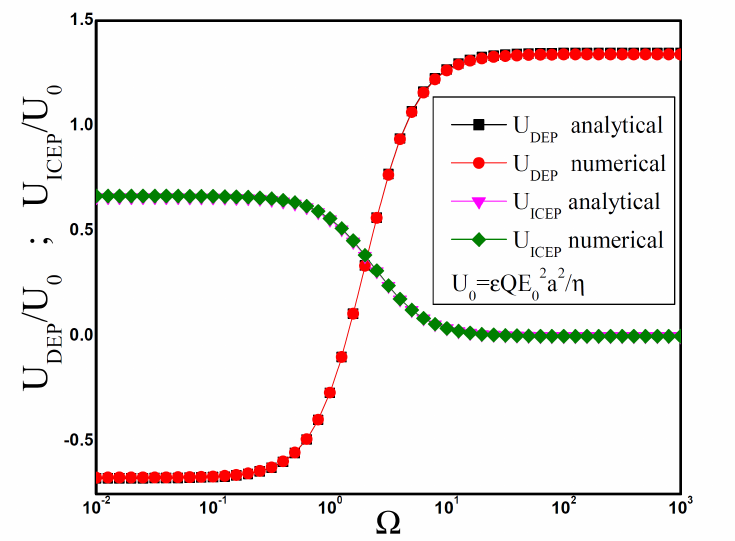
Figure 3. Dipolophoresis of a metal sphere as a function of angular frequency of the applied ac field. Analytical and numerical results are compared. The velocity is non-dimensionalized with U 0 = ε QE 2 a 2 / η 0